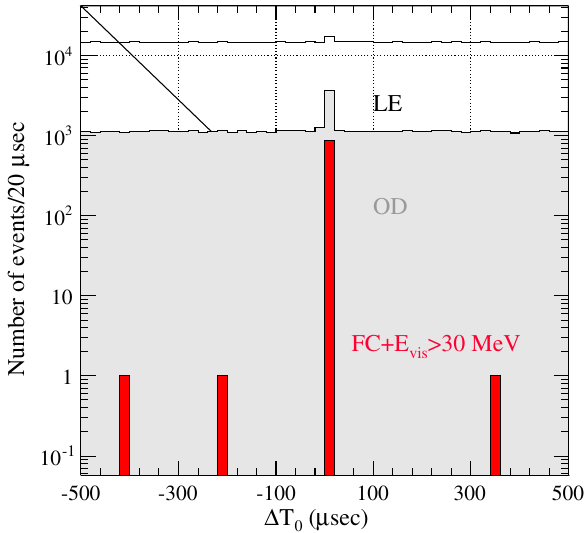
Fig. 65 The time difference ( Δ T 0 ) between the neutrino observation and production after subtracting the TOF offset during T2K Run 1-7 [62]. The histograms are stacked